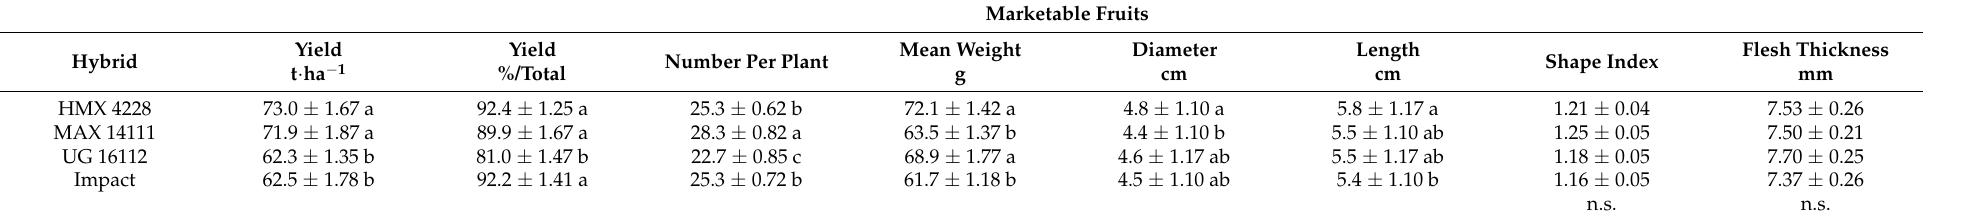
Table 1. Yield and biometrical parameters of processing tomato hybrids.